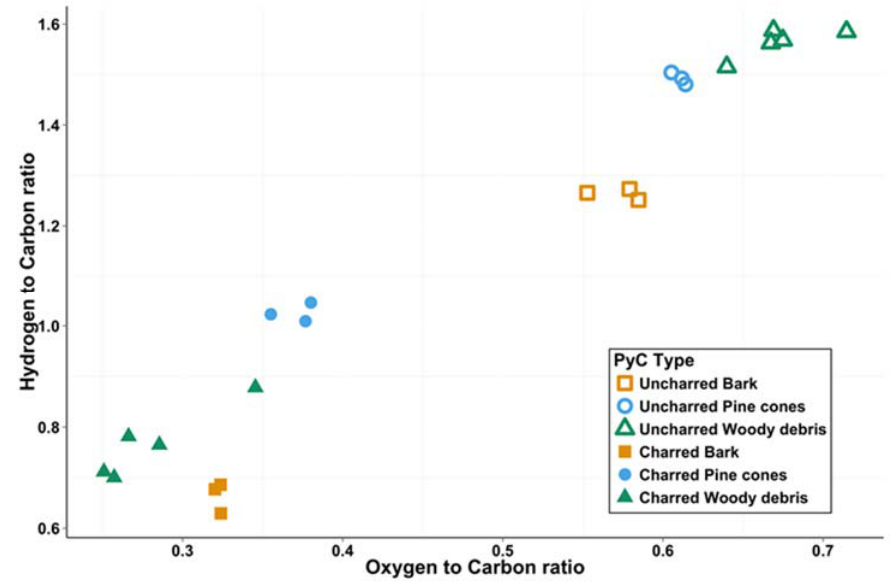
Figure 2. Van Krevelen diagram of uncharred and charred (open and filled symbols, respectfully) bark (yellow), charred pine cones (blue), and charred woody debris (green). The ratios on the axes are expressed as atomic percent of the